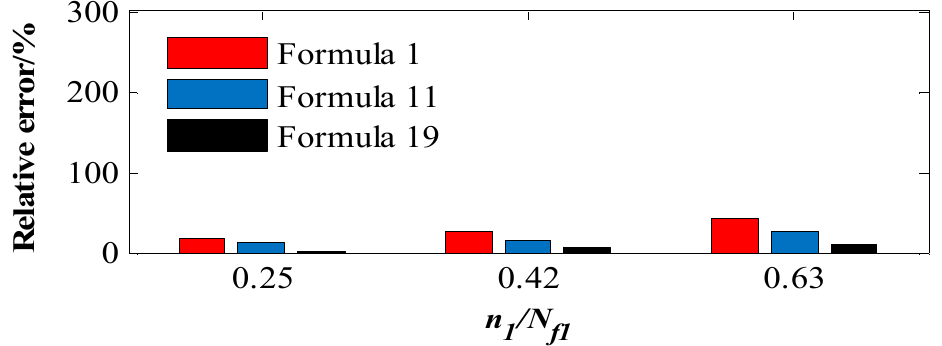
Figure 10. (420–520 MPa) The relative error of each model under different n 1 /N f 1 (18CrNiMo7-6). It can be seen from Figures 9 and 10, for 18CrNiMo7-6 material, under high–low load loading, as the proportion of high load continues to expand, the relative error of Miner’s rule increases significantly. The relative error of the tough dissipation model is also grad- ually increasing, but the overall value is smaller than Miner’s rule. The relative error be- tween the result obtained by the improved model and the actual value is the smallest among these three models. In the case of low–high loading, the error between the results obtained by the three models and the actual value is smaller than the error obtained in the 0.750 0.25 0.50